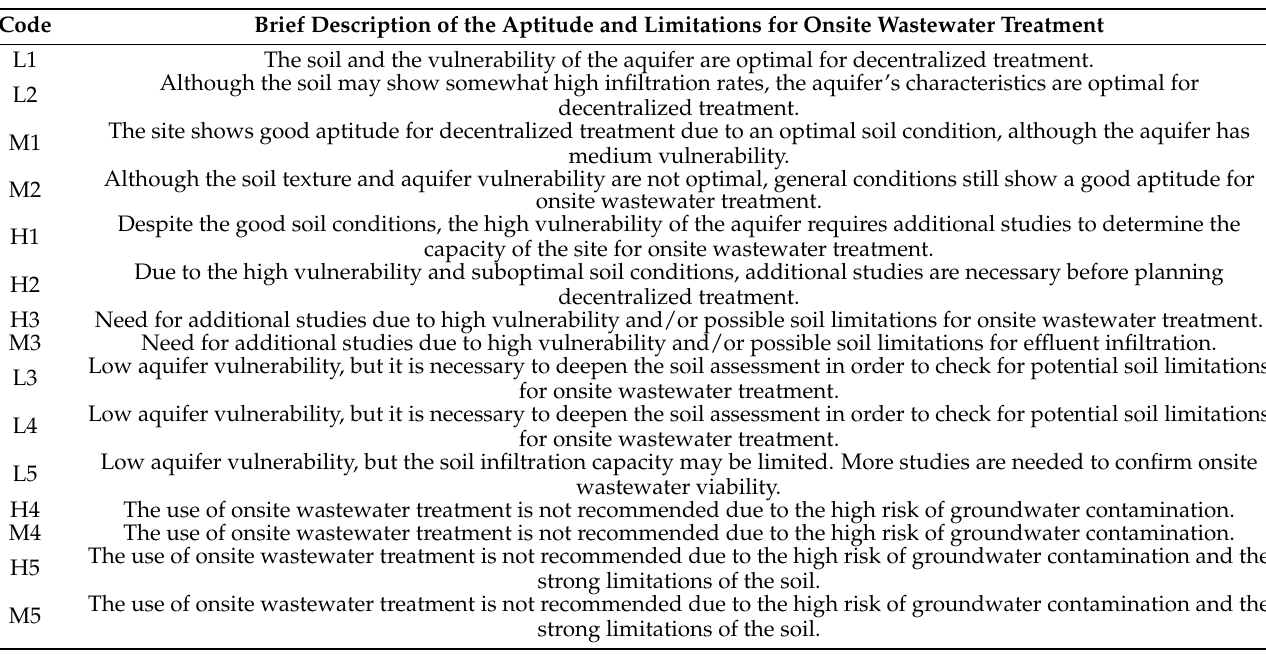
Figure 3. Possible combinations between soil texture and aquifer vulnerability categories. Green: acceptable aptitude for ODWST, Yellow: further examination is needed, Red: no suitable for OD ‐ WTS. The codification of Aptitude factors is described in detail in Table 1. Table 1. Classification codes for onsite wastewater planning.